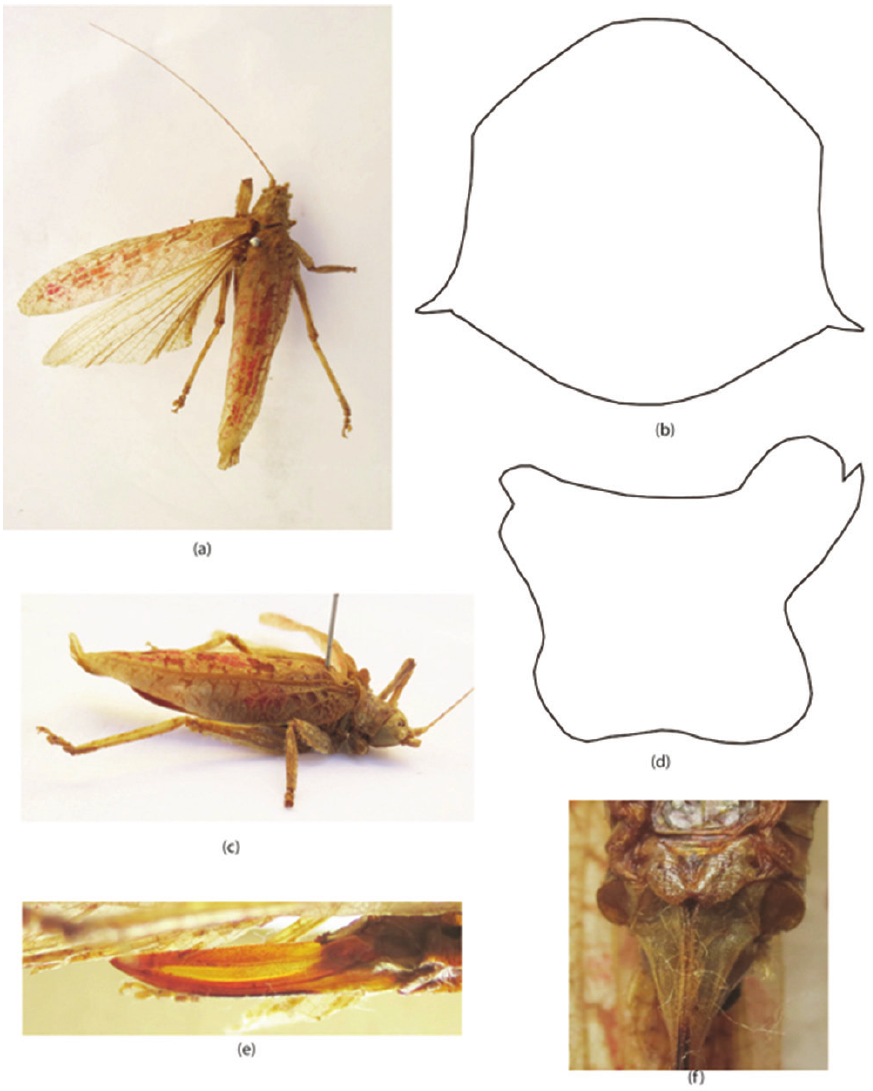
Figure 4. Sathrophyllia irshadi sp. n. female a adult DV b pronotum DV c adult LV d pronotum LV e ovipositor LV f subgenital plate